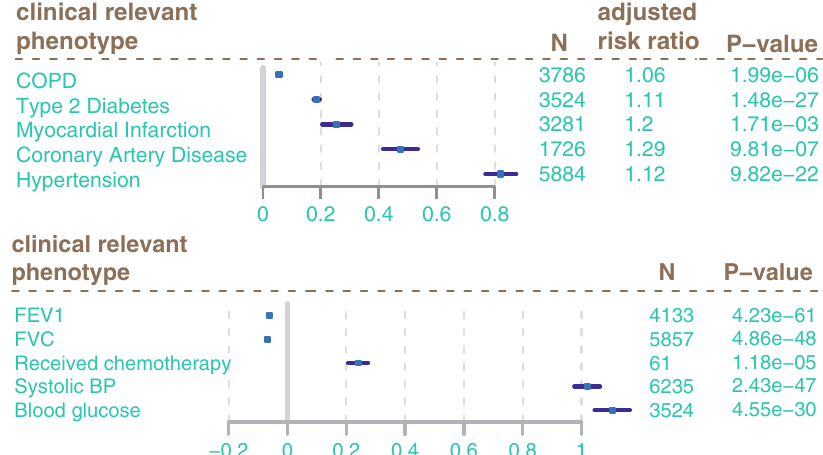
Fig. 5 Associations of CRP DNA methylation signature to clinically relevant phenotypes. Forest plots give estimate from logistic regression (logODDs) and con fi dence intervals (error bars) of CpG risk score regression against relevant phenotypes. N is the number of samples included in analysis. To produce adjusted relative risk estimates we transformed odds ratios as follows: RR = odds ratio/1 − (lifetime risk) + (life time risk × odds ratio). Those estimates indicate the theoretical maximum impact of the discovered CpG signature (100% DNA methylation change) on the tested traits. The risk conveyed by one percent change in the DNA methylation risk score on the tested traits was 1.007% for COPD, 1.7% for T2D, 2.9% for myocardial infarction 4.3% coronary artery disease, and 0.2% for hypertension. For continuous traits such as FEV1, FVC, systolic BP, and blood glucose estimates from linear regression including con fi dence intervals are